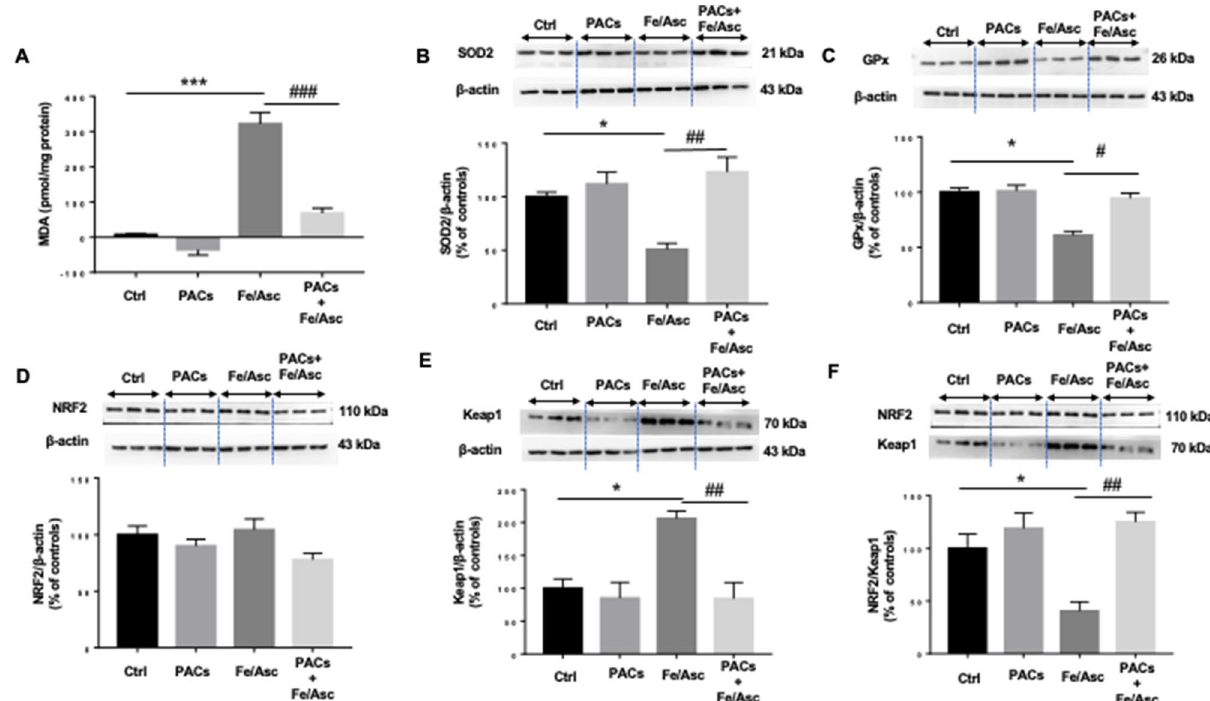
Figure 2. Effects of PACs on lipid peroxidation, endogenous antioxidants, and oxidative stress key transcription factors in Caco-2/15 cells. Proanthocyanidins (PACs, 250 µg/mL) were added to the apical cell compartment for 24 h prior to treatment with Fe/Asc (200 µM/2 mM) for 6 h at 37 °C. Lipid peroxidation was determined by measuring ( A ) MDA levels by HPLC. The protein expression of ( B ) SOD2, ( C ) GPx, ( D ) NRF2 and ( E ) Keap 1 was determined by Western blot. ( F ) The ratio NRF2/Keap1 was calculated. Results represent the means ± SEM of 3 independent experiments, each in triplicate. A representative Western blot is shown, illustrating an experiment in triplicate on the same gel and with the same exposure. *P < 0.05; ***P < 0.001 vs untreated cells (ctrl). # P < 0.05; ## P < 0.01; ### P < 0.001 vs Fe/Asc-treated cells. MDA malondialdehyde, SOD2